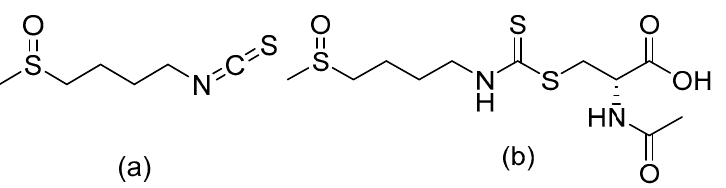
Figure 1. Chemical structures of ( a ) Sulforaphane (SFN) and ( b ) Sulforaphane N -acetylcysteine (SFN-NAC).